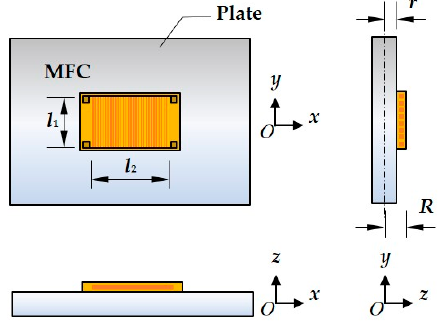
Figure 2. MFC laminated plate structure.